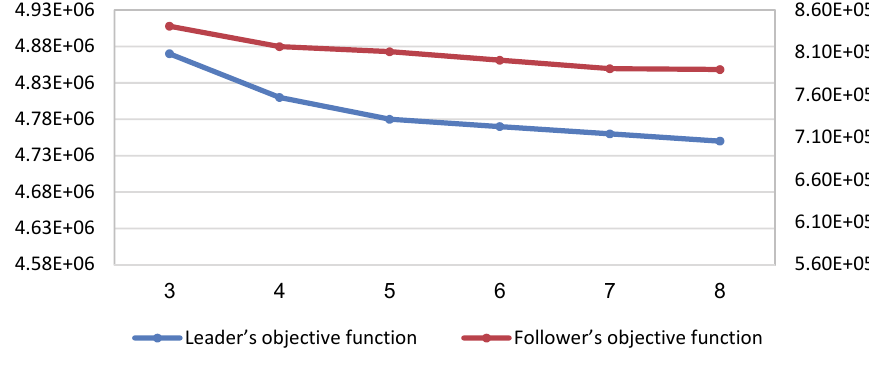
Fig. 5. Impact of warehouses radius coverage on optimal bi-level model